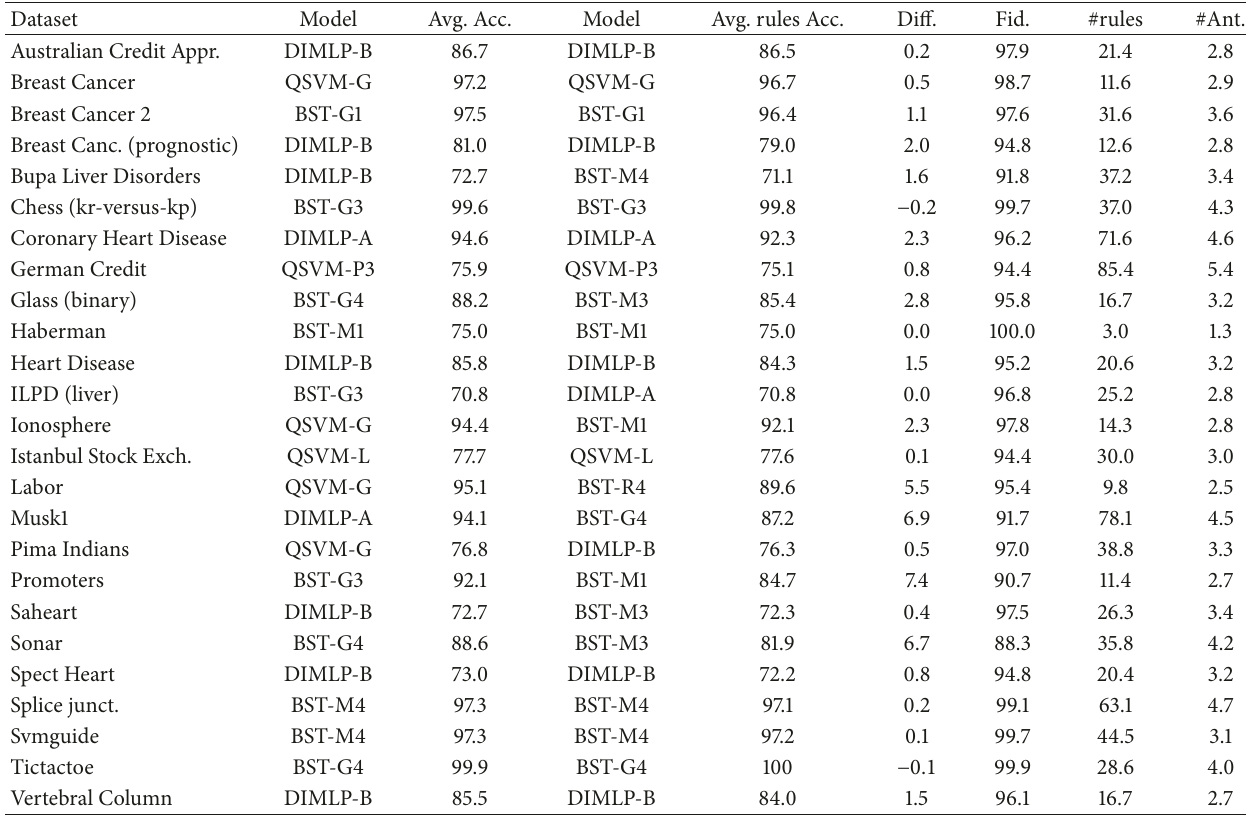
Table 2: Comparison between the average predictive accuracy obtained by the best model (column three) and the average predictive accuracy of the best extracted rulesets (column five). The last three columns indicate the average fidelity, the average number of generated rules, and the average number of antecedents per rule, respectively.